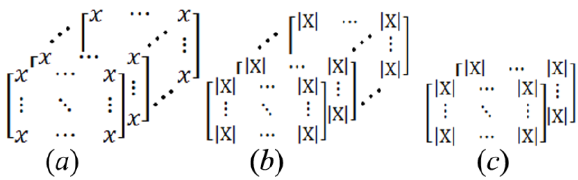
Figure 3. (a) Hyperspectral image matrix, (b) FFT Amplitude of hyperspectral matrix, (c) Abstract of FFT Amplitude matrix